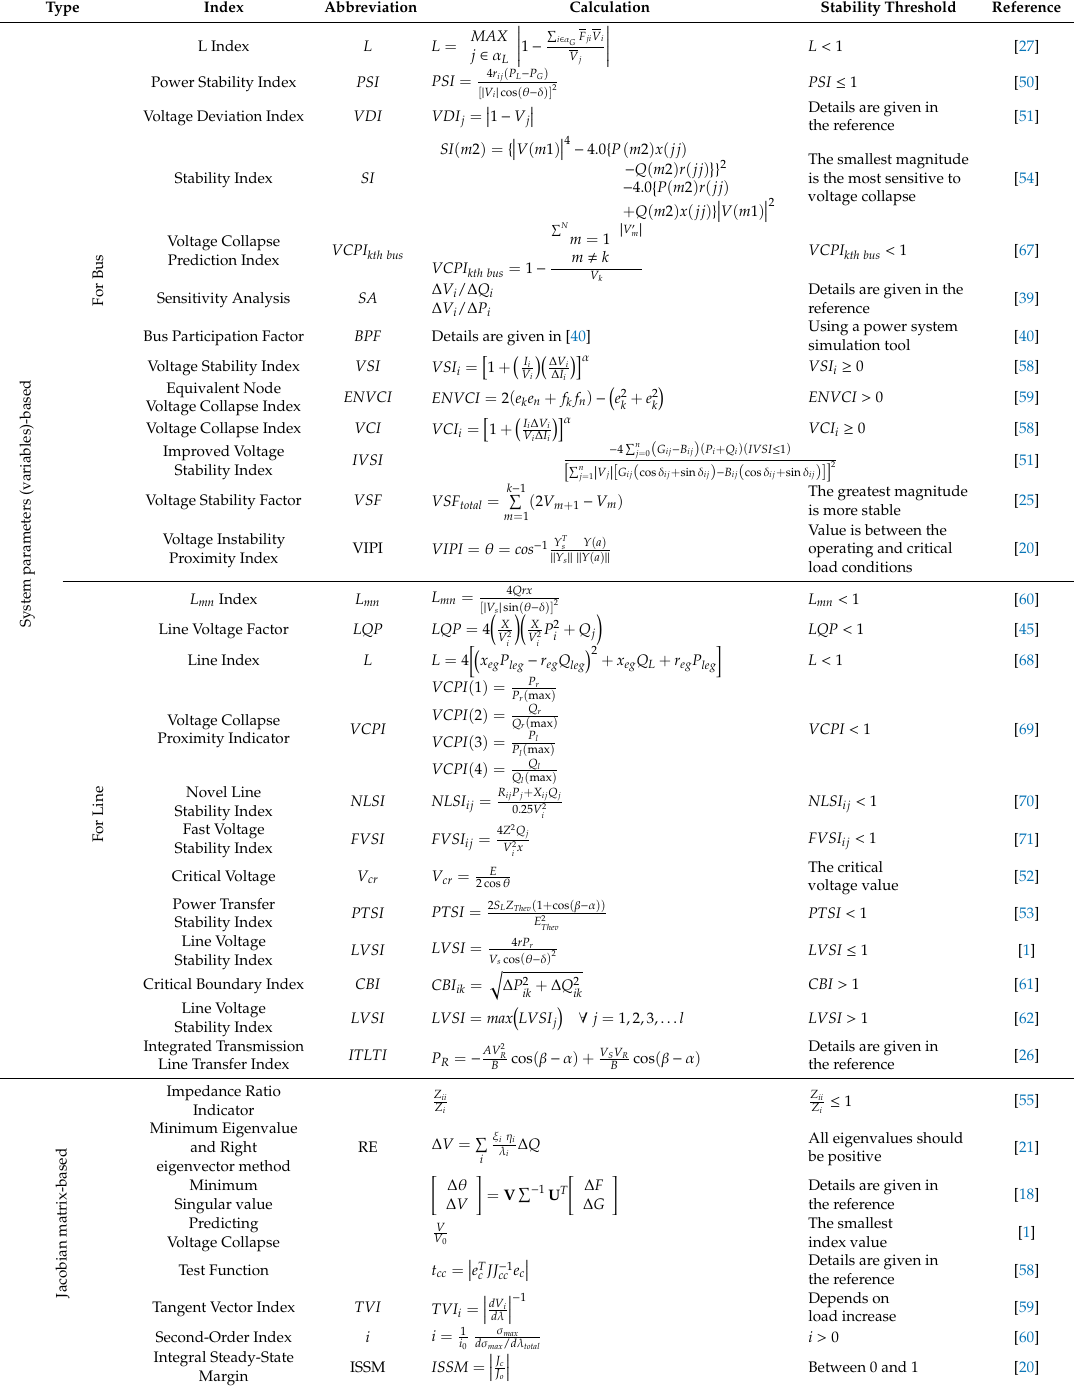
Table 1. An exhaustive representation and classification of voltage stability